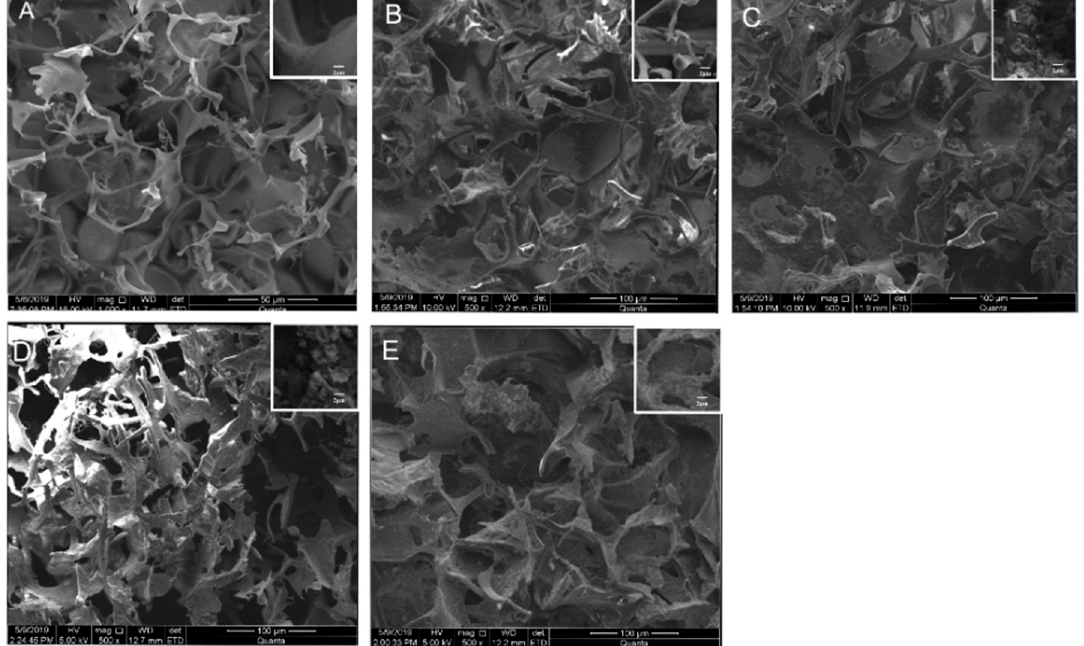
Figure 2. Surface morphology of the silk fibroin/soy protein isolate (SF/SPI)-based composite scaffolds (( A ): SF; ( B ): SF/SPI; ( C ): SF/SPI/graphene oxide (GO); ( D ): SF/SPI/ β -tricalcium phosphate ( β -TCP);